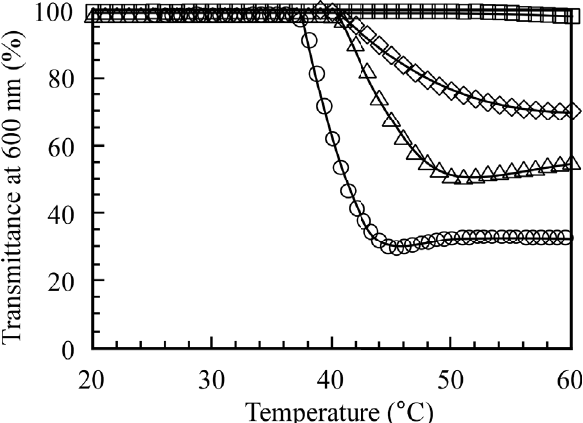
Figure 6. Percent transmittance ( T %) at 600 nm for 0.1 M NaCl aqueous solutions of PMPC -PDEA ( ○ ), PMPC 64 66 at C = 5.0 g/L as a function of temperature. p